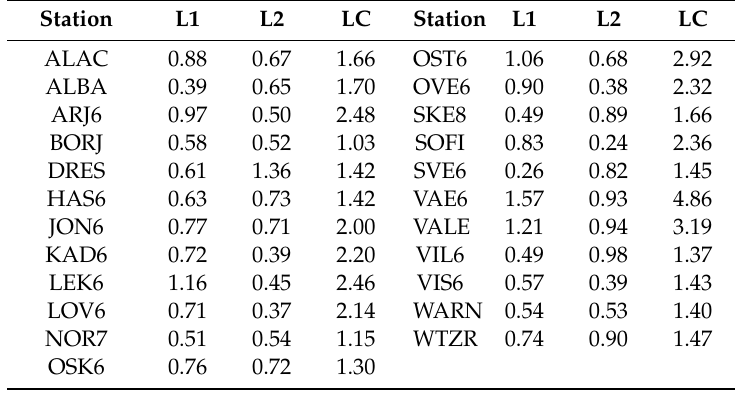
Table A1. Total RMSs of the di ff erences between compared phase center corrections for both GPS frequencies (L1 and L2) and “ionosphere-free” linear combination (LC). Values are in millimeters. Station L1 L2 LC Station L1 L2 LC